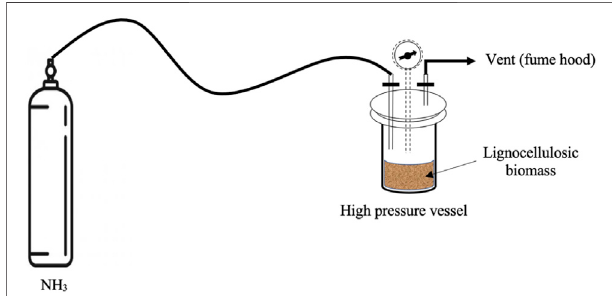
FIGURE 1 | Experimental set-up of the LMAA